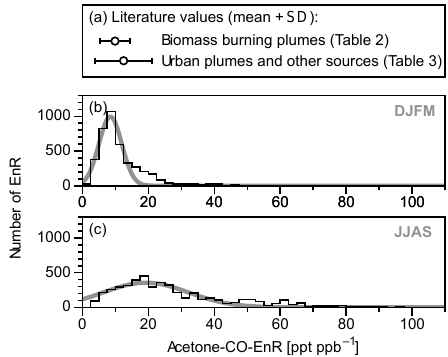
E o f be r m u N